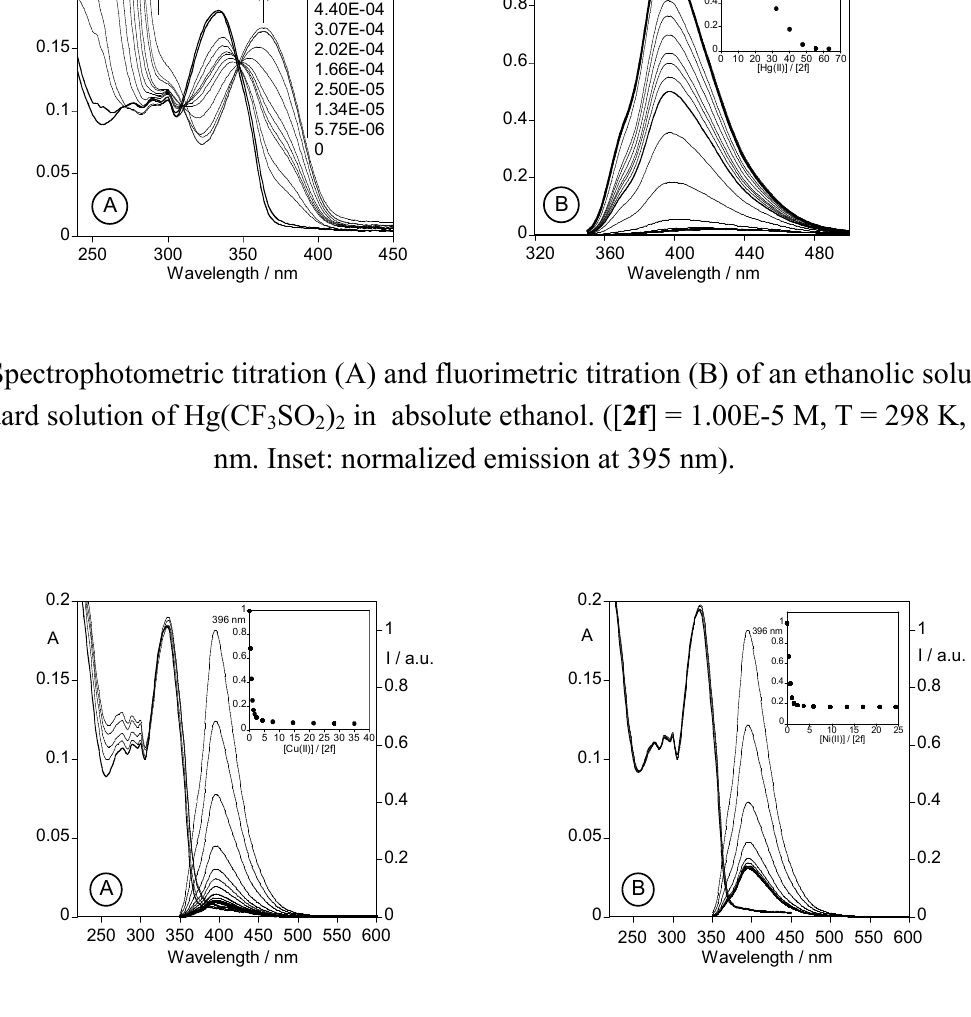
Figure 4. Spectrophotometric titration and fluorimetric titration of an ethanolic solution of 2f with a SO ) (A) and Ni(BF ) (B) in absolute ethanol. ([ 2f ] = 1.00E-5 M, T = standard solution of Cu(CF 3 2 2 4 2 298 K, λ = 334 nm. Insets: normalized emission at 396 nm in both exc